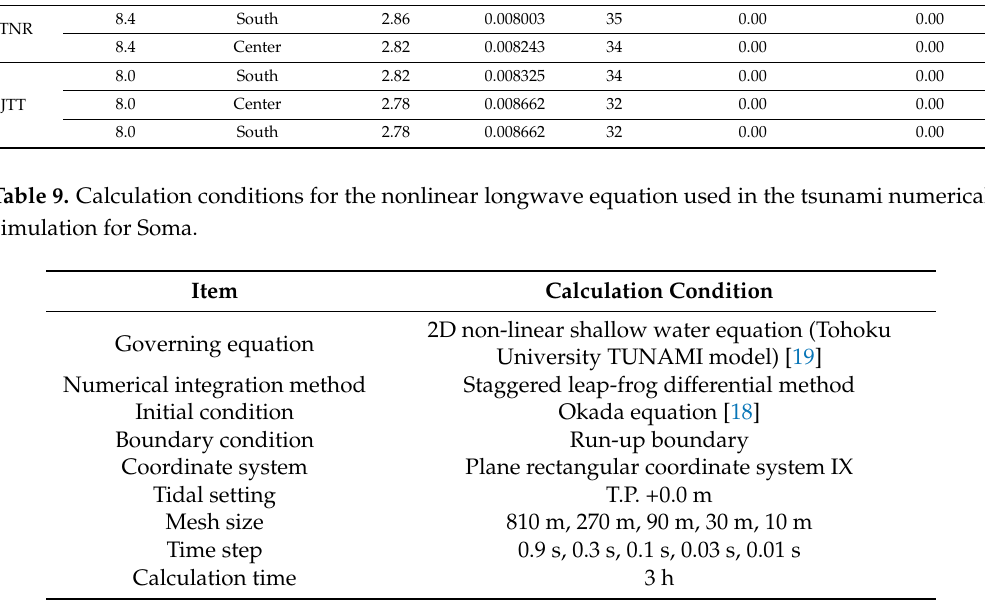
Table 10. Calculation conditions for the nonlinear longwave equation used in the tsunami numerical simulations for Sendai and